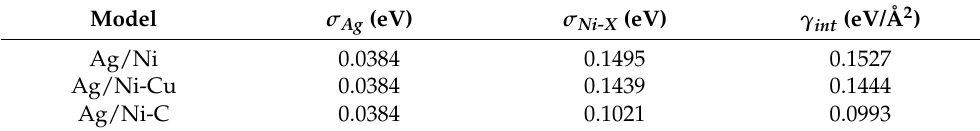
Table 3. Interfacial energy.